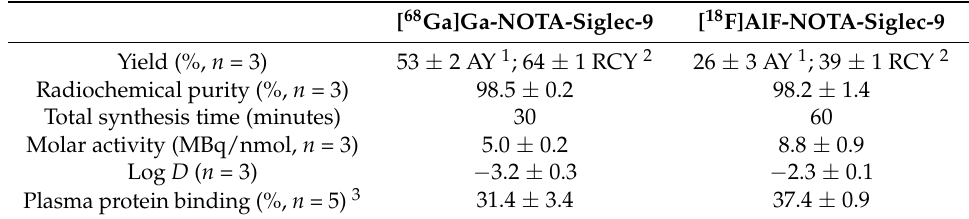
Table 1. Properties of [ 68 Ga]Ga-NOTA-Siglec-9 and [ 18 F]AlF-NOTA-Siglec-9.